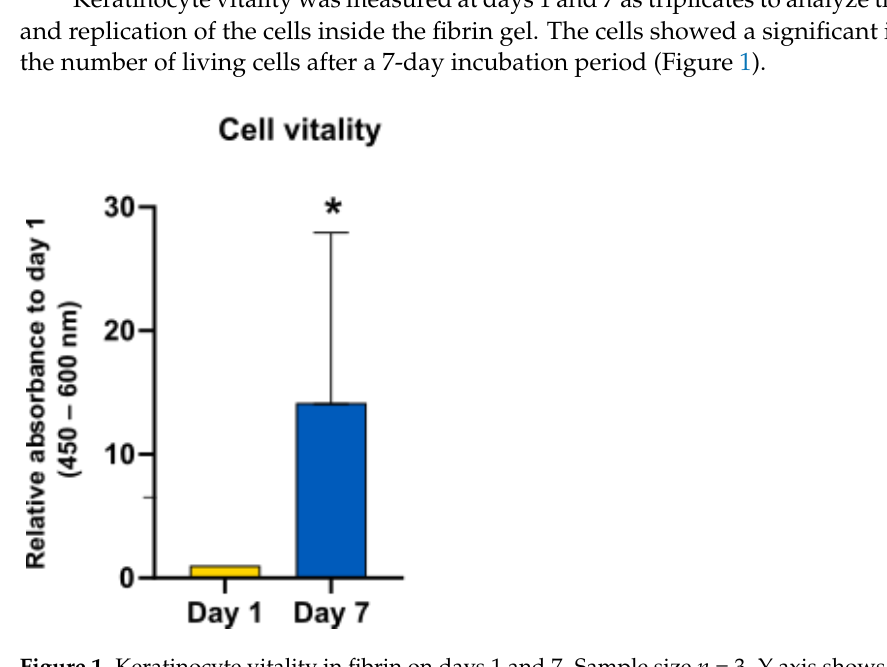
Figure 1. Keratinocyte vitality in fibrin on days 1 and 7. Sample size n = 3. Y-axis shows absorbance on 1 d and 7 d. Day 1 was normalized to 1. Average and standard deviation constituted. * p ≤ 0.05, significances were correlated to the relative absorbance on day